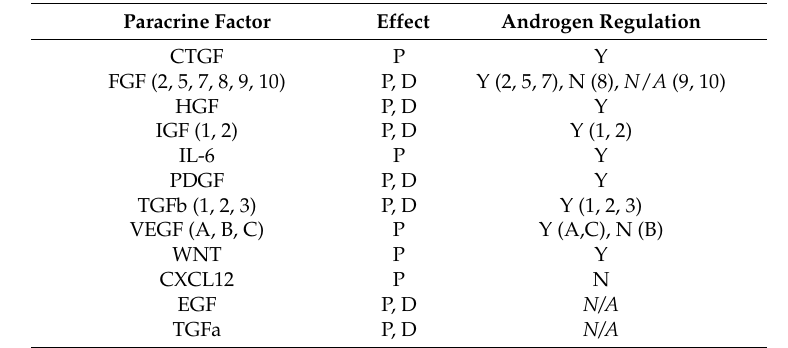
Table 3. Stromal produced paracrine factors. Proliferative effect (P), Differential effect (D) supported by [97,99,100]. Androgen regulation (Y = yes, regulated by androgen, N = no, not regulated by androgen) determined from microarray data from